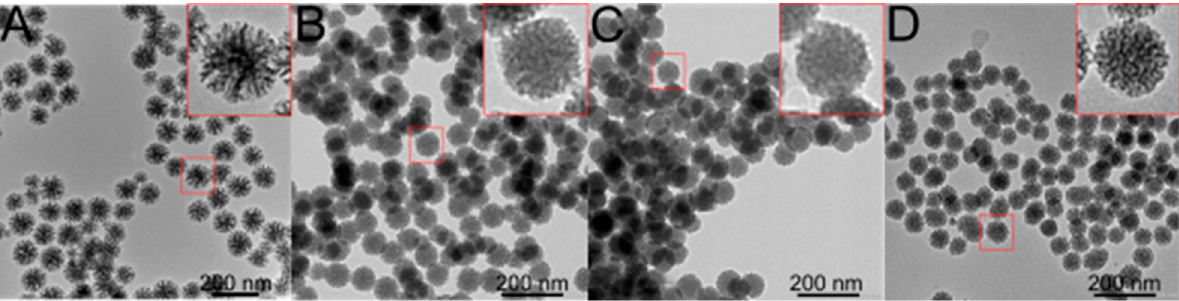
Figure 1. TEM images of: ( A ) MSN , ( B ) MSN-1c , ( C ) MSN-3c and ( D ) MSN-4a .